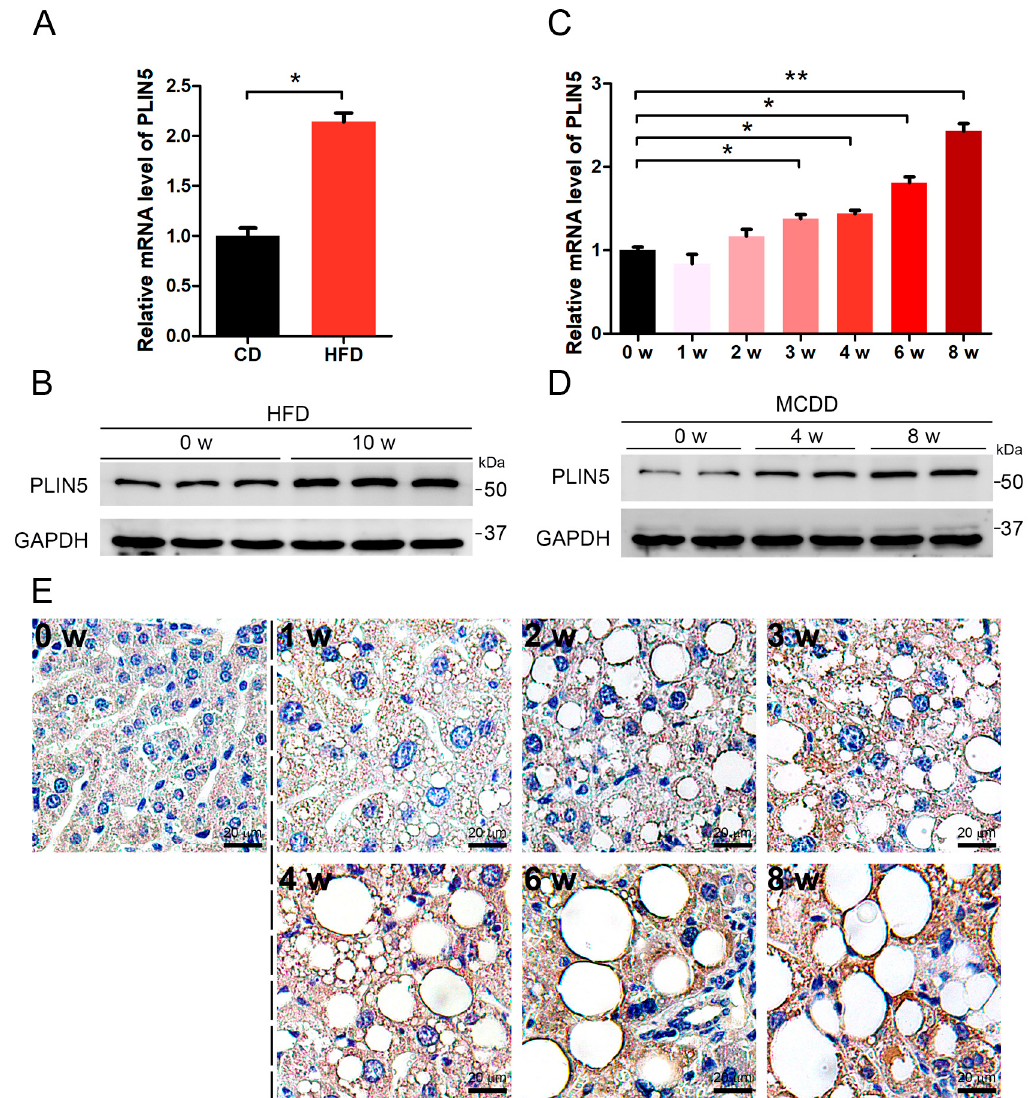
Figure 1. Perilipin 5 ( PLIN5 ) was up-regulated in liver tissues of non-alcoholic fatty liver disease (NAFLD) mice. ( A ) Six-week-old C57 / bl male mice were fed with a high-fat diet (HFD) or chow diet (CD) for 10 weeks. The mRNA levels of PLIN5 in liver tissues of mice fed with chow diet (CD) and HFD were detected by qRT-PCR. ( B ) The protein levels of PLIN5 in liver tissues of mice fed with chow diet (CD) and HFD were detected by Western Blot. ( C ) Six-week-old C57 / bl male mice were fed with methionine-choline-deficient diet (MCDD) for 1 week, 2 weeks, 3 weeks, 4 weeks, 6 weeks, and 8 weeks, respectively. The mRNA levels of PLIN5 were detected by qRT-PCR. ( D ) The protein levels of PLIN5 were detected by Western Blot. ( E ) Immunohistochemistry analysis of liver tissues of mice fed with MCDD (1–8 weeks) and control mice (0 week). Scale bar, 20 µ m. These experiments were performed in triplicate. * p < 0.05; and ** p < 0.01.